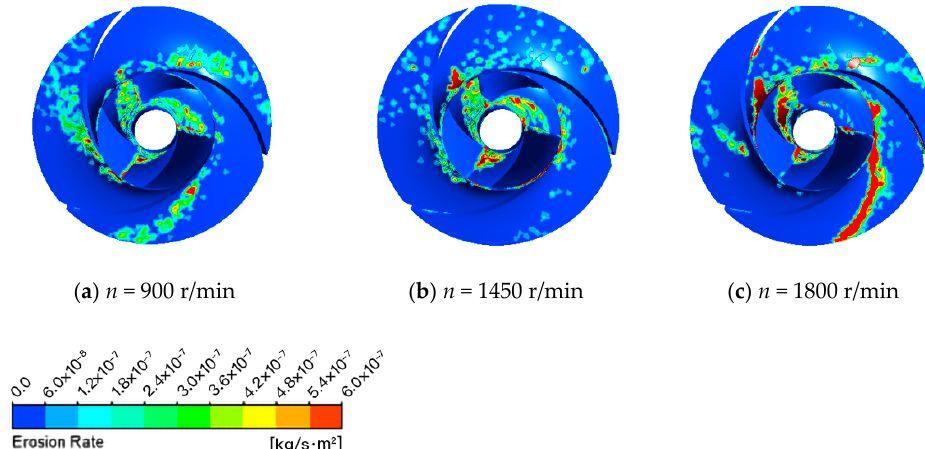
Figure 20. Wear distribution on the impeller surface.